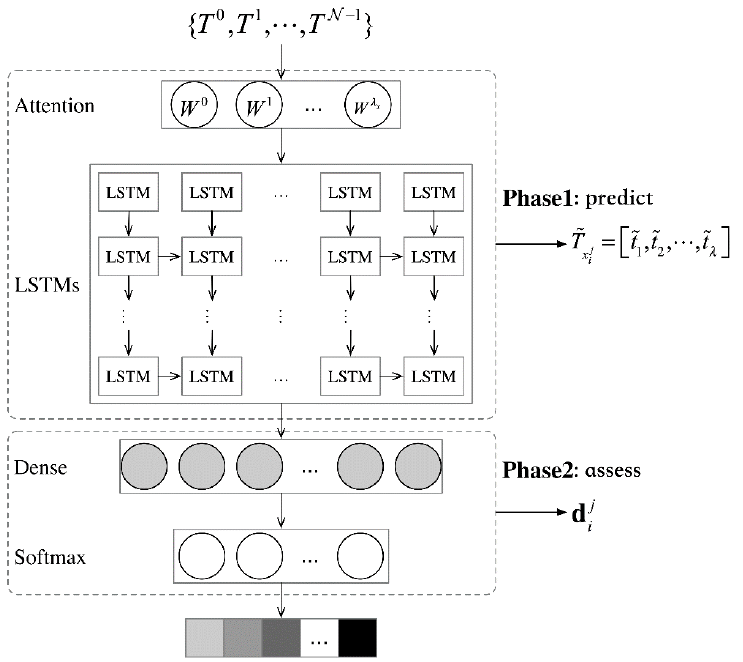
Figure 5. The diagnosis model of single node.